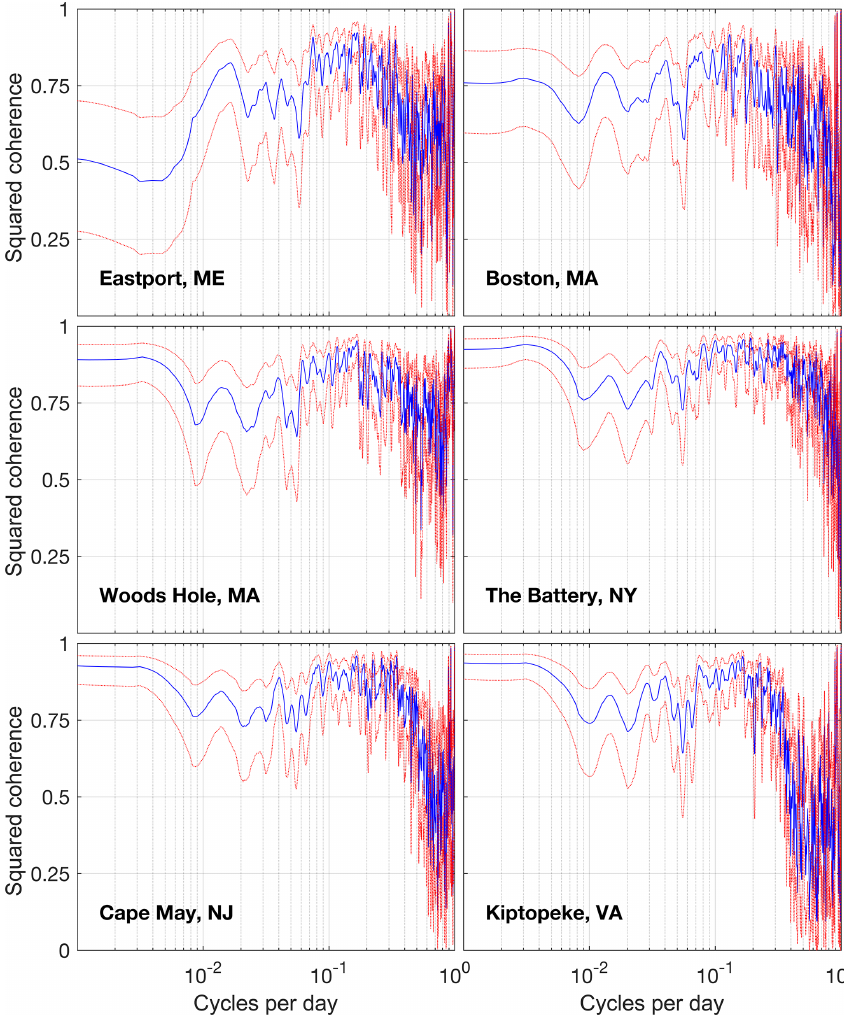
Figure 9. Sea level coherence (in blue; error bars in red) along the domain’s coastline from tide gauge data against model output. Tide gauge locations are noted in bold in Fig.